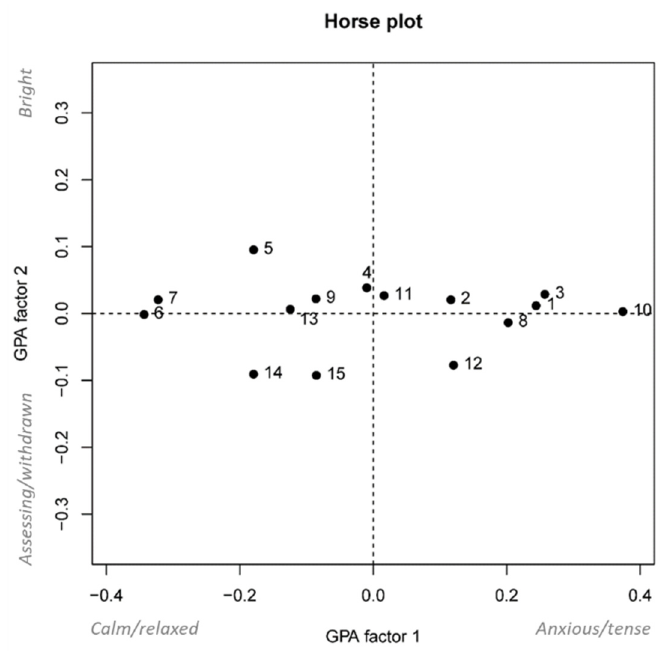
Figure 2. Horse plot shows the individual horses positioned on the two main GPA factors.